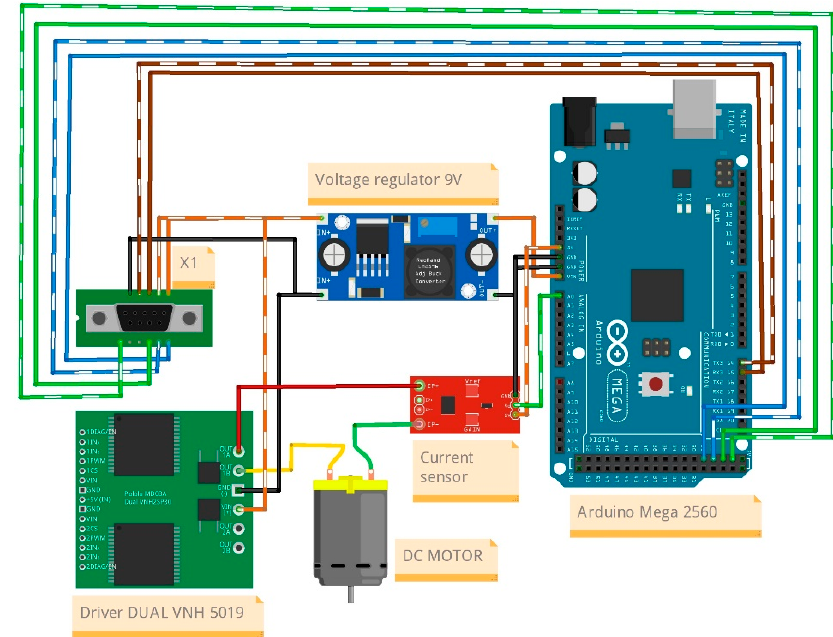
Figure 11. Electrical diagram of the actuation module.